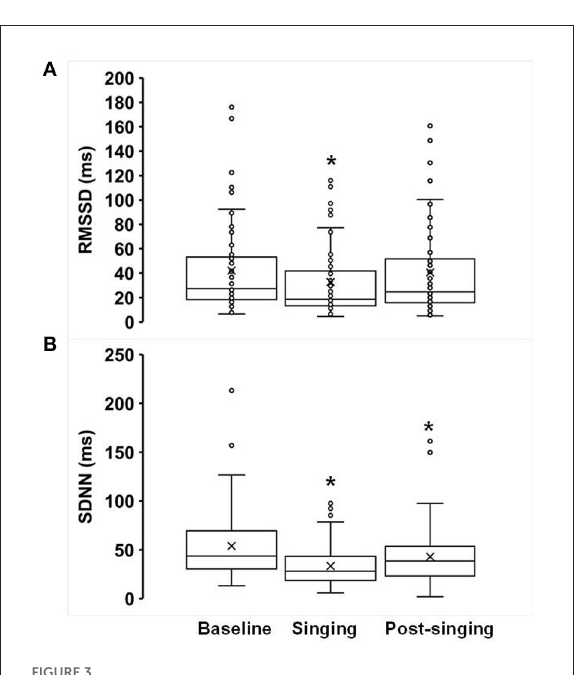
FIGURE3 Effects of singing on heart rate variability (A) RMSSD and (B) SDNN. Box plots showing the following values: the mean (x), median, upper quartile (Q3), lower quartile (Q1), minimum and maximum whiskers as well as outliers. * p <